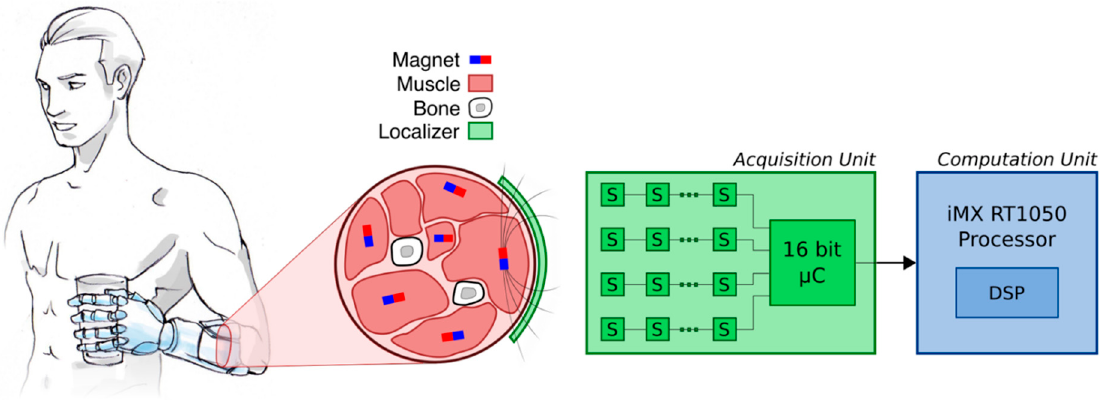
Figure 1. Embedded system architecture. Overview of the embedded myokinetic control interface for a prosthetic hand. Permanent magnets are implanted in relevant residual muscles and their magnetic field is acquired by a matrix of sensors (“S” on the acquisition unit) in order to compute (computation unit) their position. In the target application—in a prosthetic hand—this information could be used to control its movements in physiologically appropriate manner.